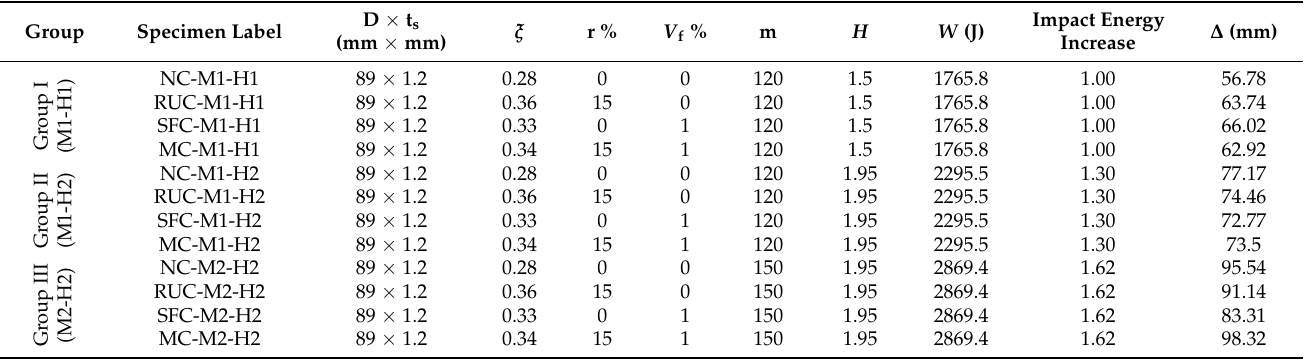
Table 1. Data and results of tested specimens.